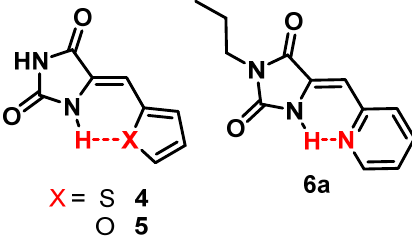
Figure 9 . Hydantoin derivatives prepared experimentally. Figure 9. Hydantoin derivatives prepared